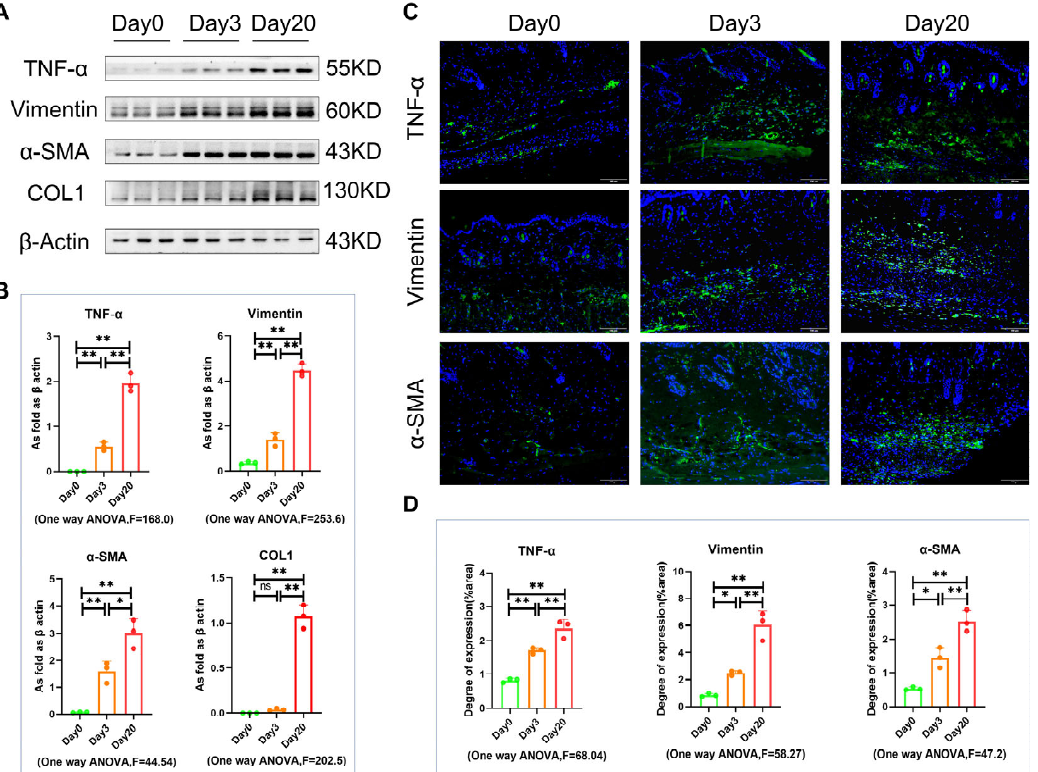
Figure 3. ( A , B ) Western blotting detected the relative protein expression levels of TNF- α , vimentin, α -SMA, and COL1 in the skin of mice on days 0, 3, and 20 of LL-37 administration. ( C , D ) Immunoflu- orescence method to detect the relative expression levels of TNF- α , vimentin, and α -SMA in mouse skin. Data are presented as the mean ± SD; n = 3 for each group. * p < 0.05, ** p < 0.01.